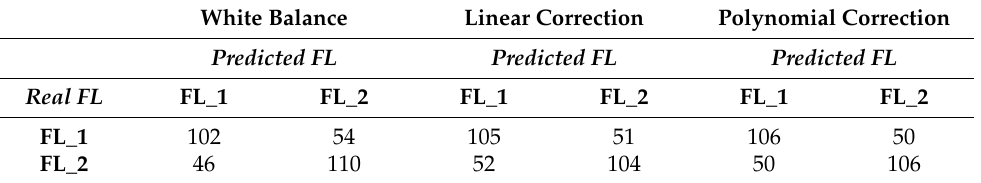
Table 7. The table shows the Confusion Matrices obtained by the classification working on distin- guishing the different fertilization levels (FL_1 vs. FL_2) using the sensor-based irrigation manage- ment from datasets provided by the three different color correction